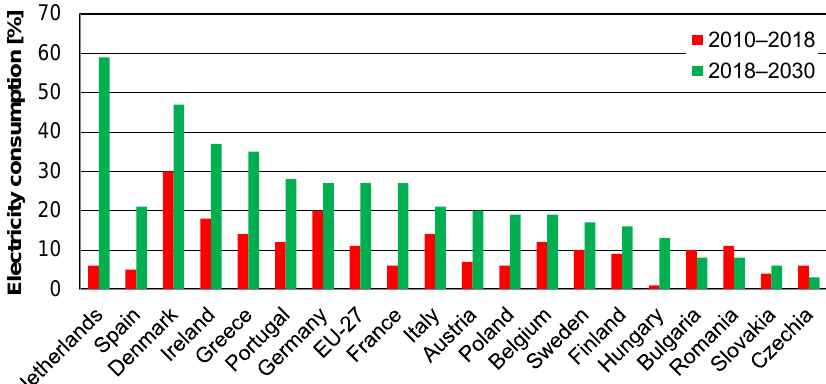
Figure 4. Renewables growth in Europe 2010–2018 and 2018–2030 [21]. Reprinted with permission from [21]. Copyright 2020, Ember.